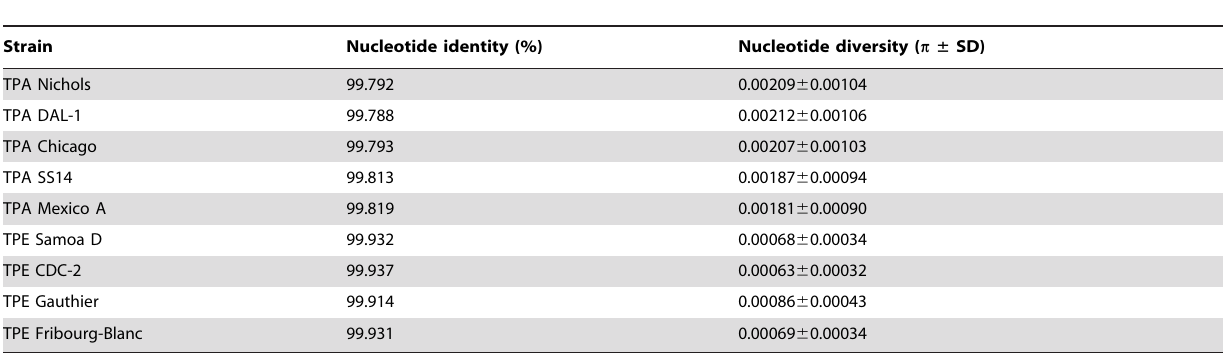
Table 3. Calculated nucleotide identity and nucleotide diversity ( p 6 standard deviation) between Bosnia A strain and individual TPA and TPE strains a